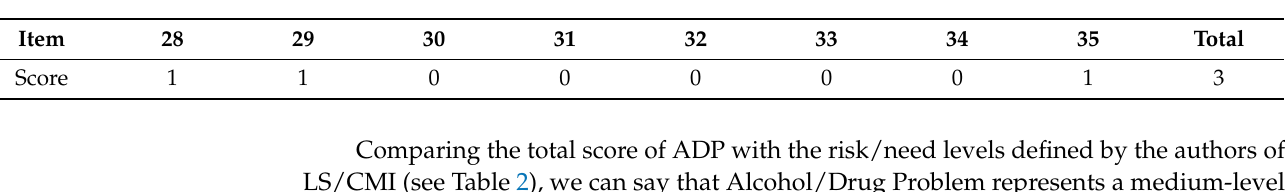
Table 7. Anna’s scores on the eight items of the subcomponent Alcohol/Drug Problem (ADP).